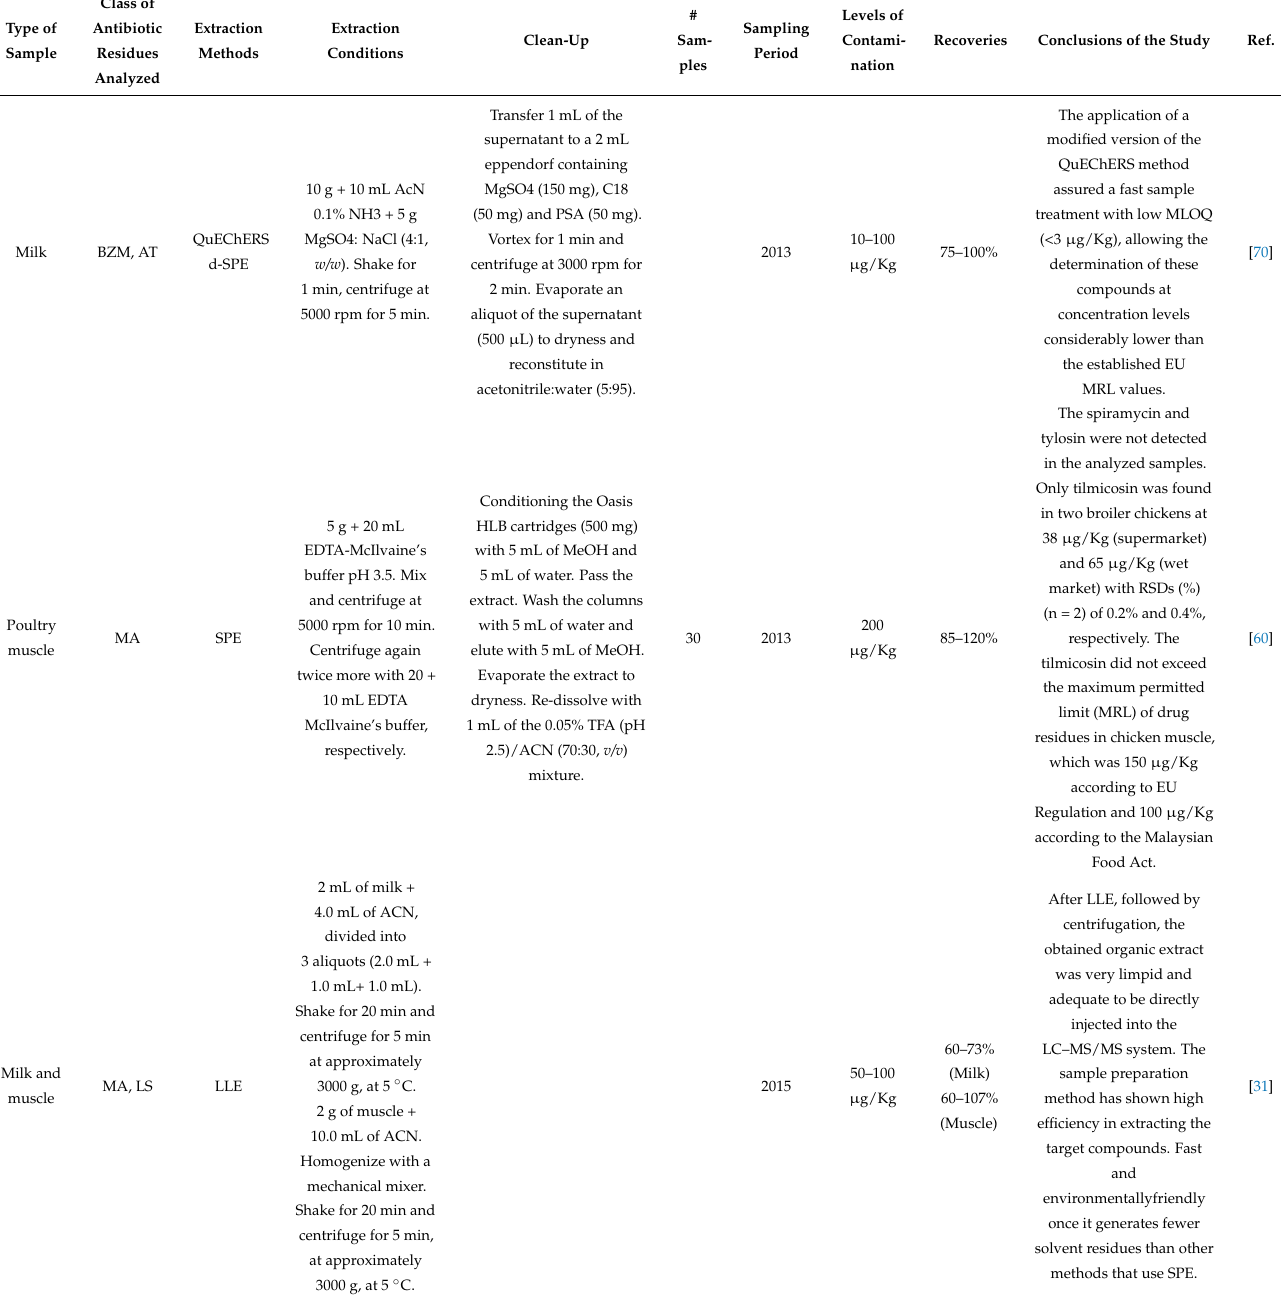
Table 2. Summary of the most common techniques currently available for clean-up and extraction of antibiotic residues in foodstuffs. The table is completed with the application of the methodology in real samples, relative levels of contamination, recovery percentages and conclusions of the study. The table was configured in chronological order for better visualization of the methodologies trends to